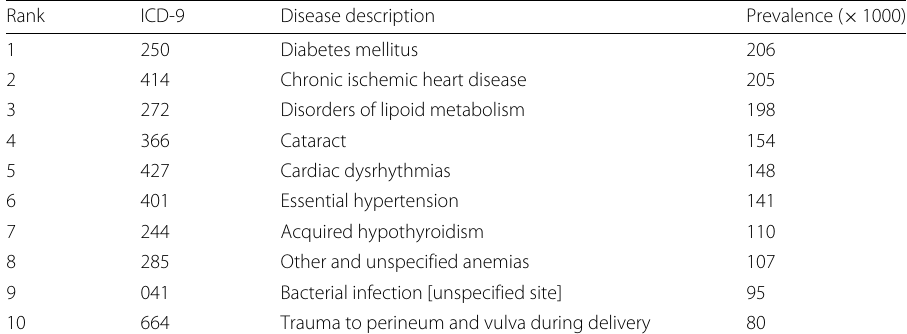
Table 1 Top 10 most-prevalent diseases in our data set Rank ICD-9 Disease